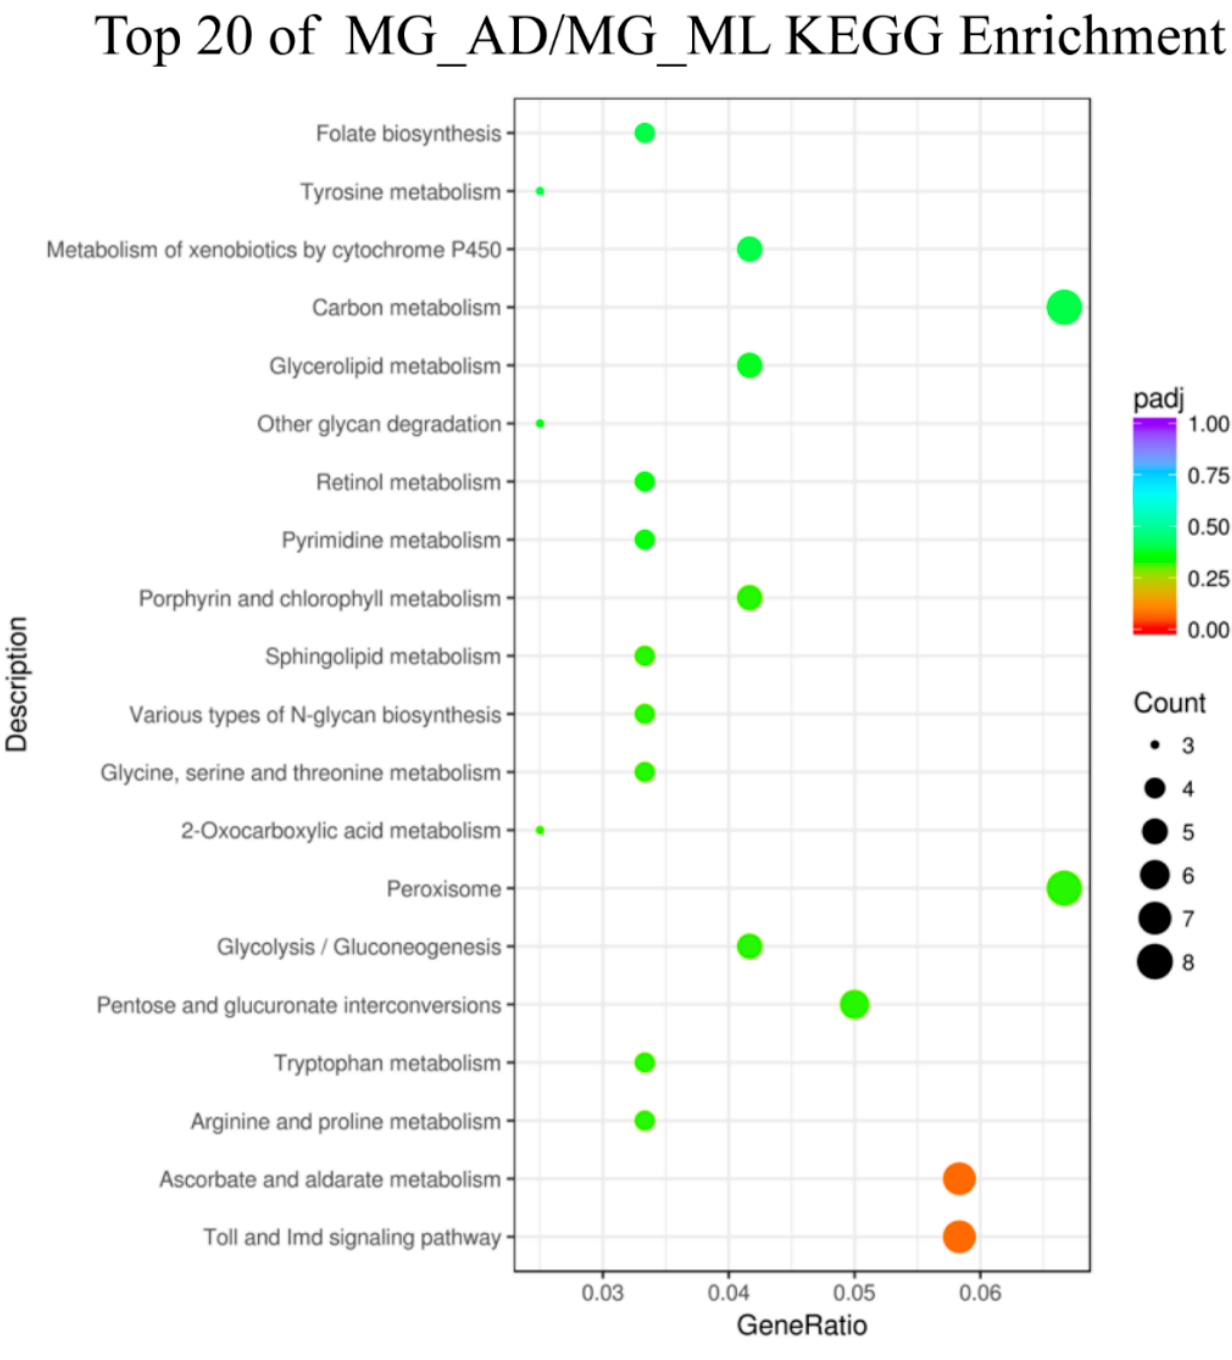
Figure 7. KEGG enrichment of MG_ADvsMG_ML. Statistics of top 20 pathway enrichment of differentially expressed genes in each pairwise. Padj is ranging from 0 to 1, and less value means greater intensiveness. The size of the plot represents the number of DEGs involved in the relevant pathway.